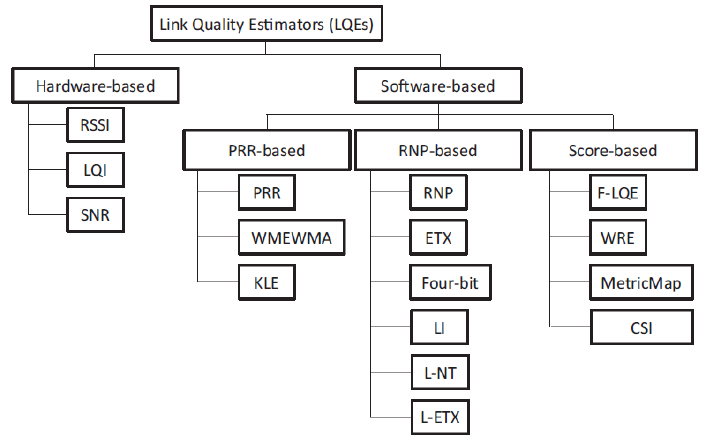
Figure 10. Available link quality estimators (LQE’s)